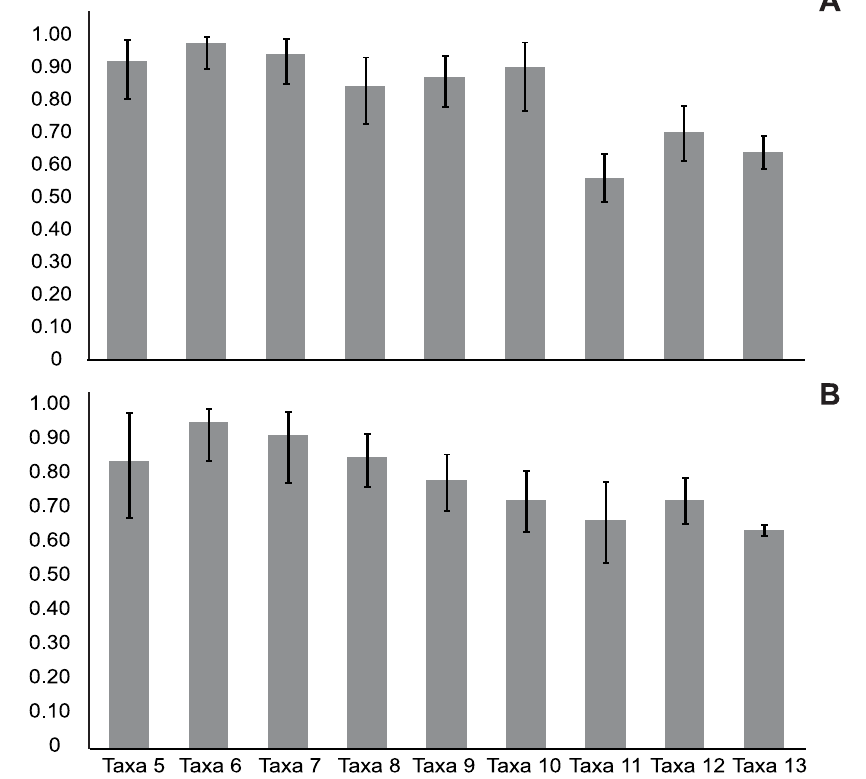
Figure 3. Mean proportion of correct classification as derived from bootstrapping with 100 iterations. Error bars represent 95% confidence interval. (A) Clusters with 5 acoustic characters. (B) Clusters with 7 acoustic characters.